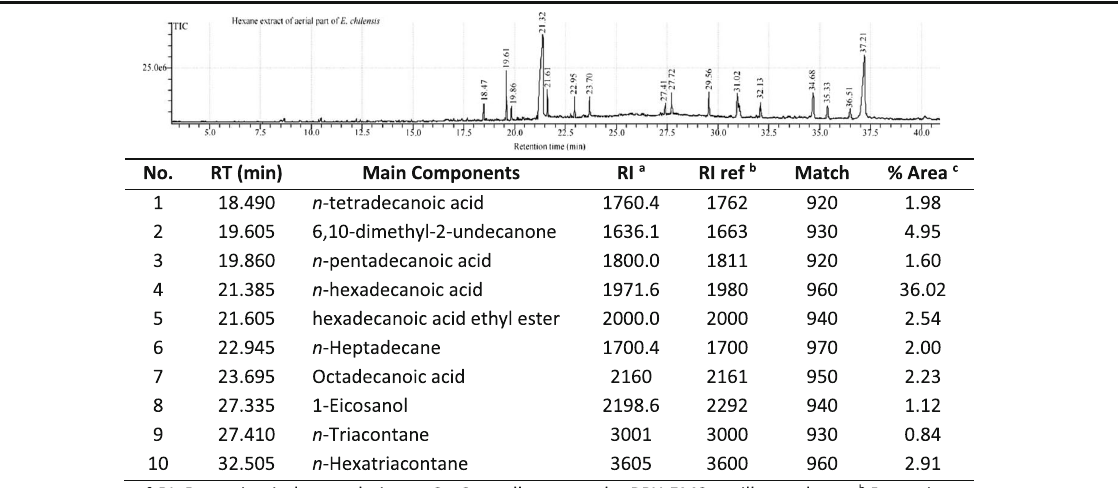
Table 7 GC-MS analysis for the n -hexane extract